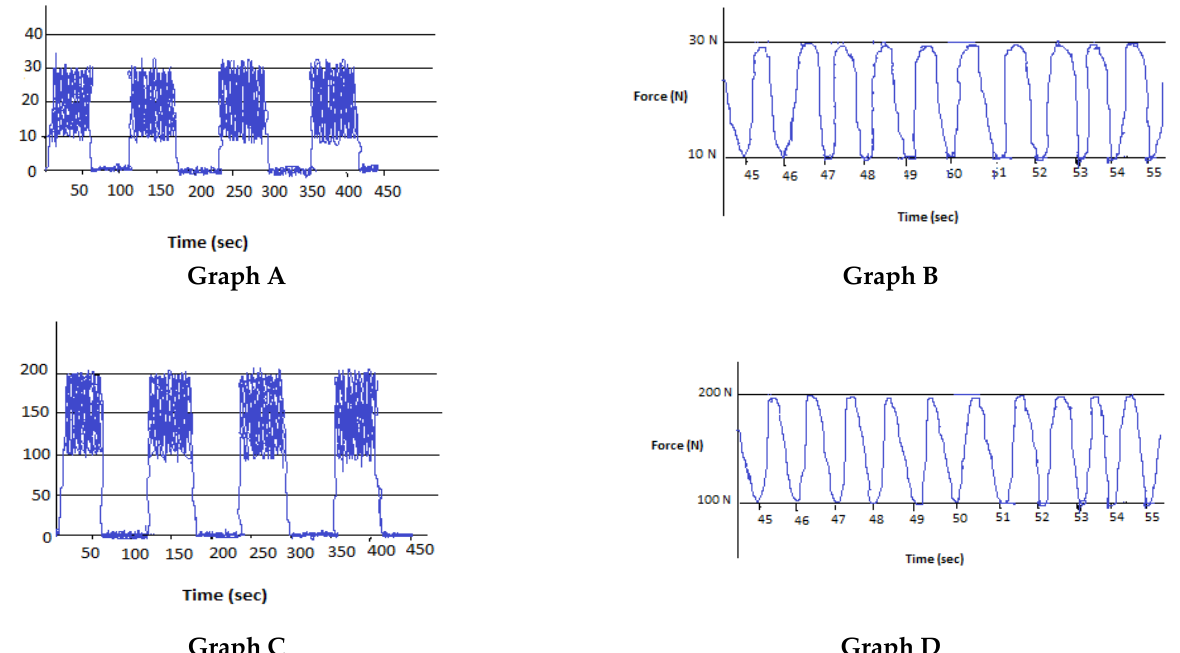
Figure 3. Typical platform recordings for the experimental conditions. Graph A : Four sets of low force mobilization. Graph B: Recording of low force oscillations from 45 s to 55 s. Graph C: Four sets of high force mobilization. Graph D: Recording of high force oscillations from 45 s to 55 s.